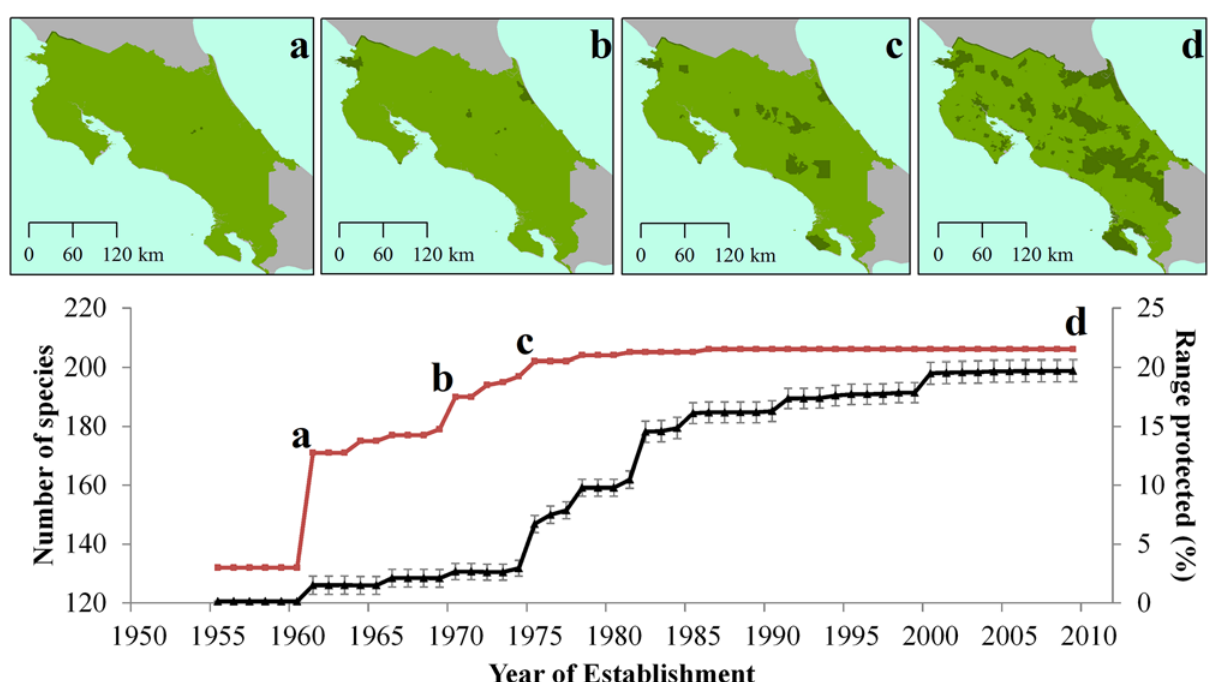
Fig 1. Chronology of protected areas establishment and number of mammal species represented in protected areas (red line), and mean percentage species ranges within protected areas (black line ± SE) in Costa Rica. Inset maps denote locations of protected areas for each major increase in number of species protected in a) 1960, b) 1970, c) 1975 and d) 2009 as also indicated in the graph.